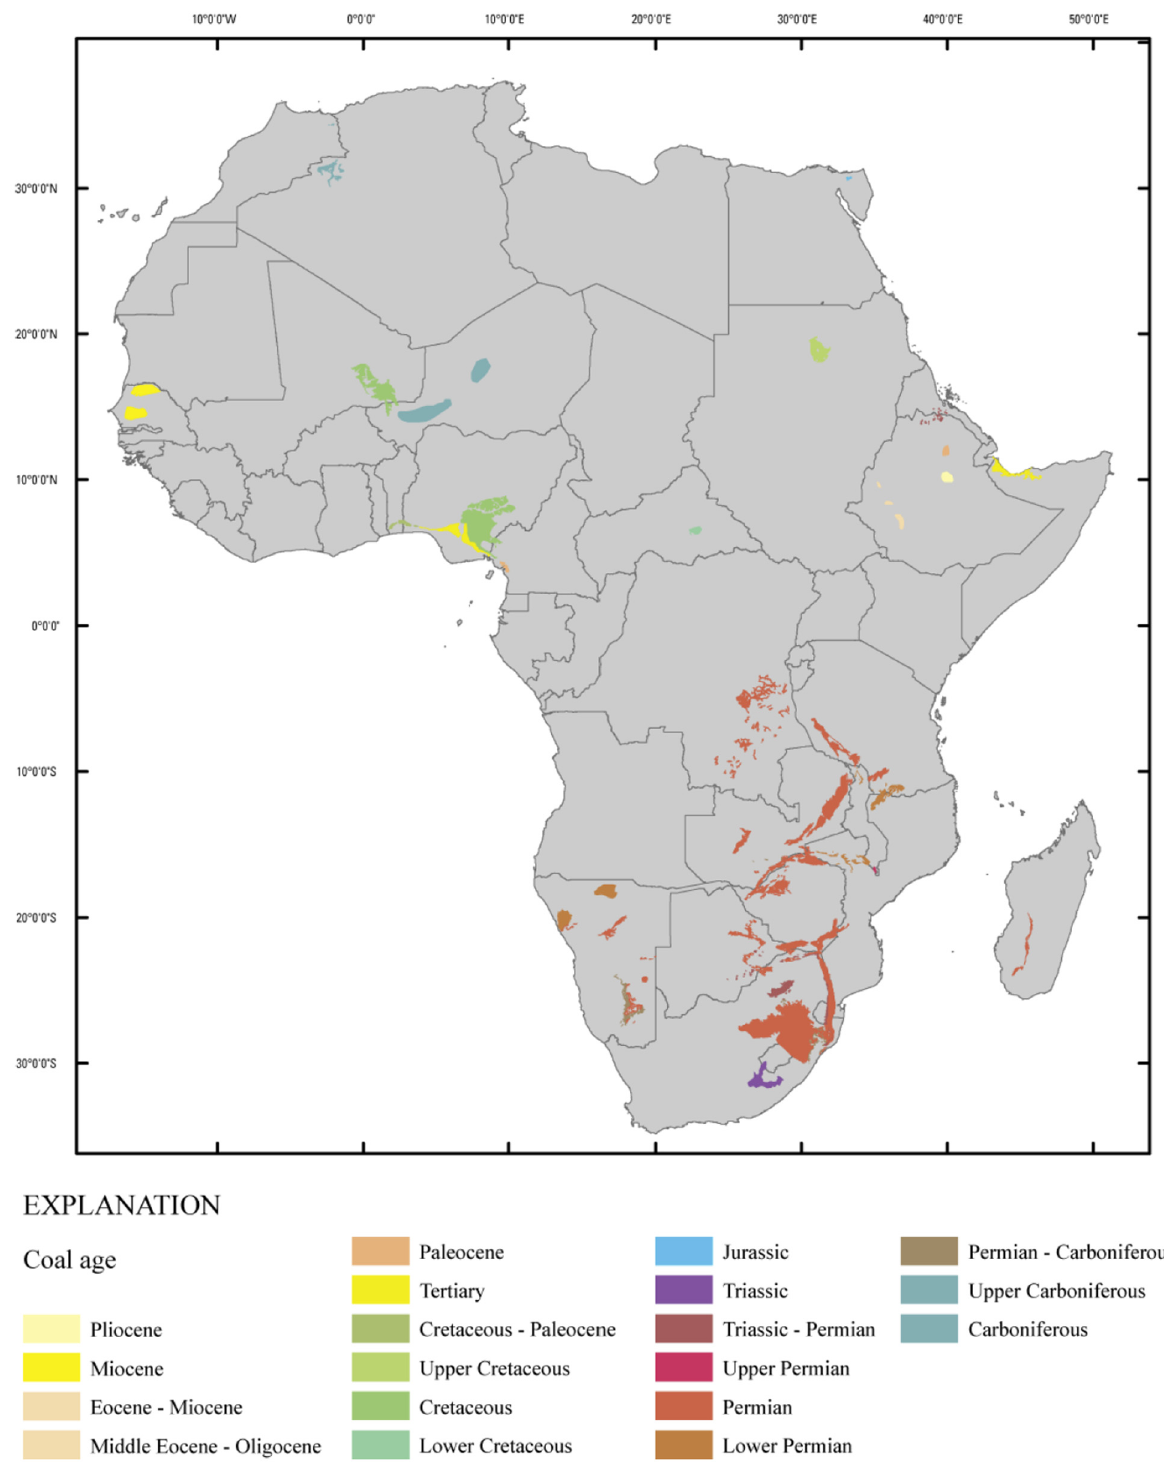
Figure 20. Distribution and ages of coal deposits in Africa [142]. The Nigerian Cretaceous-aged coal deposits are lignitic to sub-bituminous to bitumi- nous in rank [143,144], and the coal seams are usually interbedded with bands of shales and mudstones, some of which are oil-bearing. Chukwa et al. [145] reported Nigerian coal